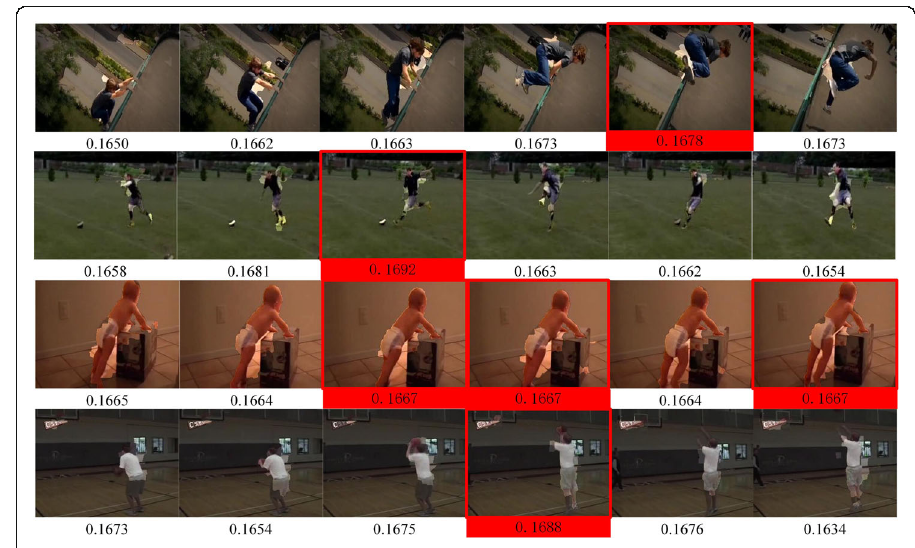
Fig. 12 Visualization of the learned weights by